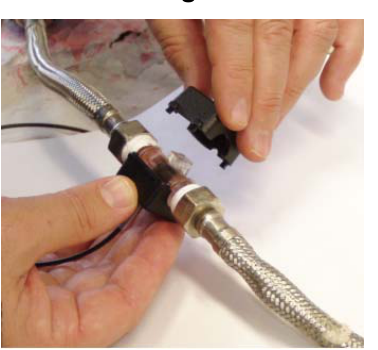
Figure 4 . Mechanical model